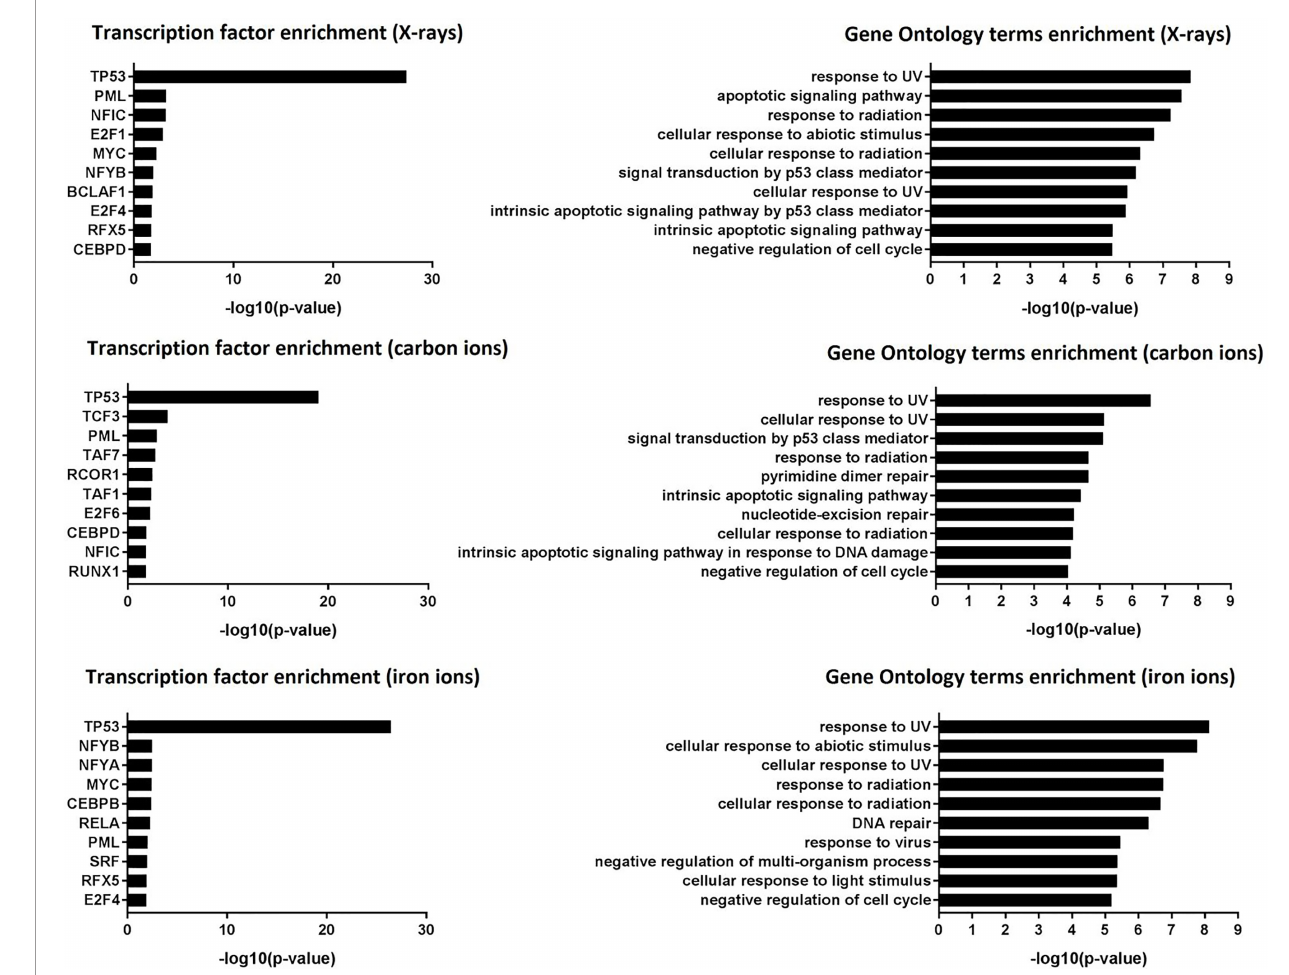
FIGURE 3 | Transcription factor enrichment and GO term enrichment. Left panel: transcription factor enrichment results following exposure to X-rays, carbon ions or iron ions. Right panel: Biological processes that are mostly affected following exposure to X-rays, carbon ions or iron ions, based on gene level